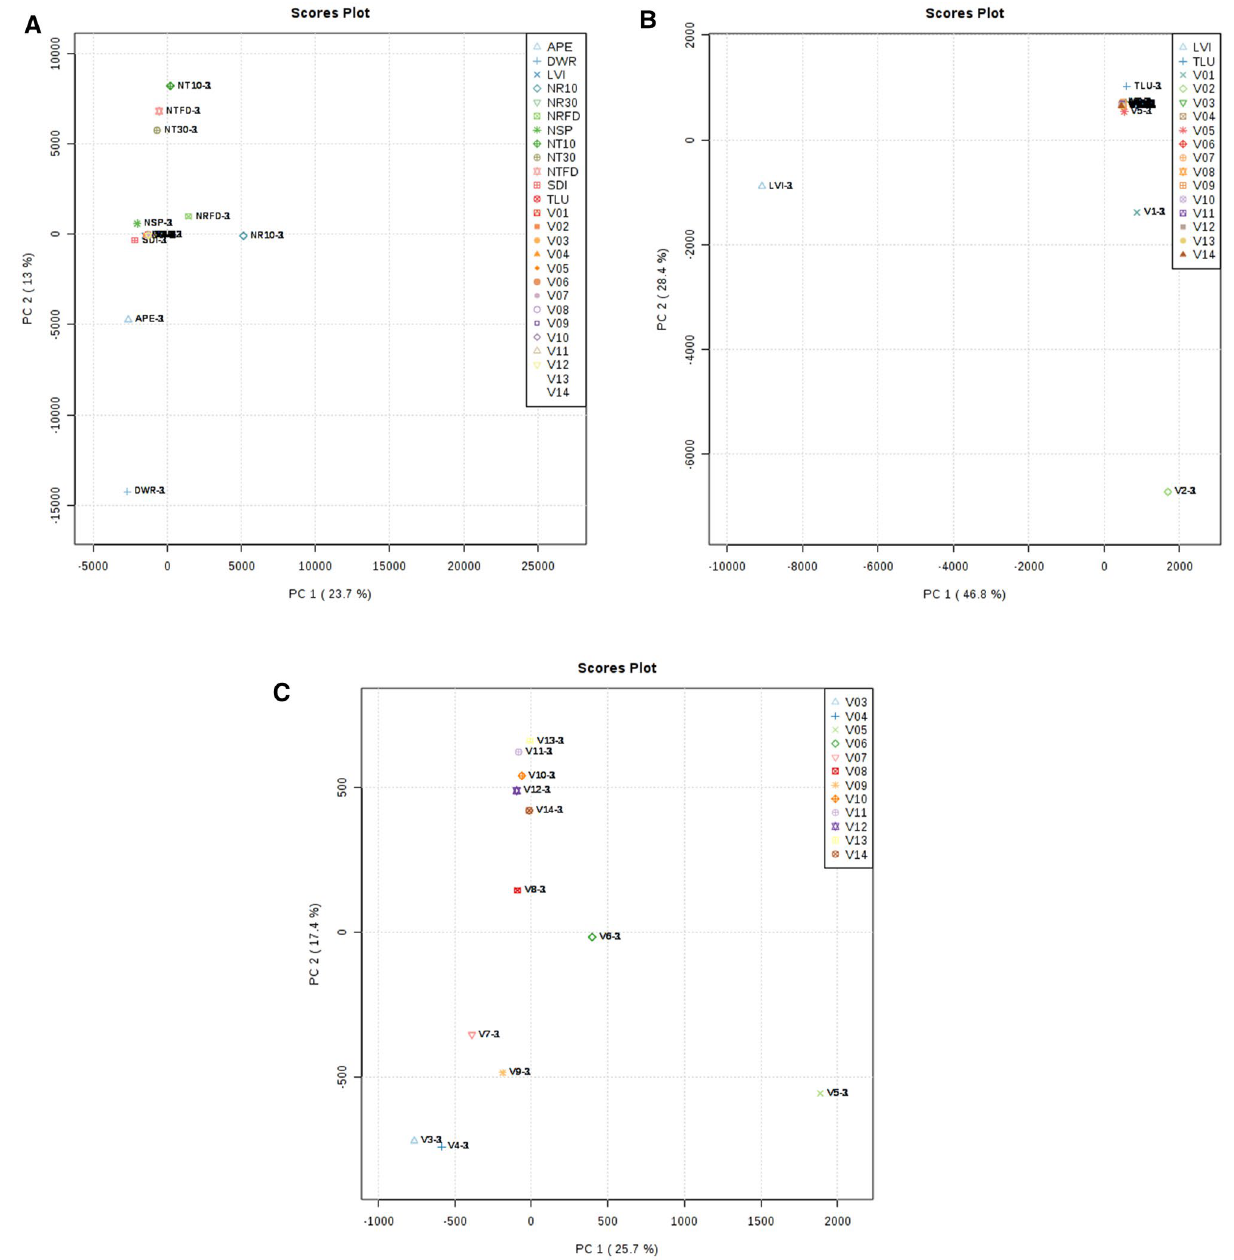
Figure 4. Principal components analysis (PCA) by MetaboAnalyst—( A ) Vessels and all references; ( B ) Vessels, TLU, and LVI; ( C ) Vessels 03-14 appear to be more similar to the diviner’s sage and the locally collected plant references. Plot B, which only retains the two modern references most similar to the archaeological samples—Mexican marigold (TLU) and the lilac tree (LVI)— shows all archaeological samples scoring quite close to each other on Component 1. However, both PASUC vessels are more distant from their “peers” than TLU. This speaks to the degree of variation in residues extracted from curated versus untreated archaeological ceramics. Only after removing both remaining refer- ences as well as Vessels 01 and 02 is it possible to discern any meaningful patterns among the PARME vessels. Plot C essentially recreates the same clusters observed in Fig. 3 with the only notable difference being Vessel 05’s distance from the rest of the group. The tight clustering of this larger group of artifacts seems to be directly related to the number of compounds reported per sample. While all modern references with the exception of LVI yielded more than 500 mass spectral features, Fig. 5 exhibits the noticeable quantitative difference between the archaeological vessels. While curated PARME flasks averaged 43 features, the untreated PASUC vessels more than doubled this mark yielding an aver- age of 97 features. In other words, the lower number of recovered residues among the PARME vessels decreases